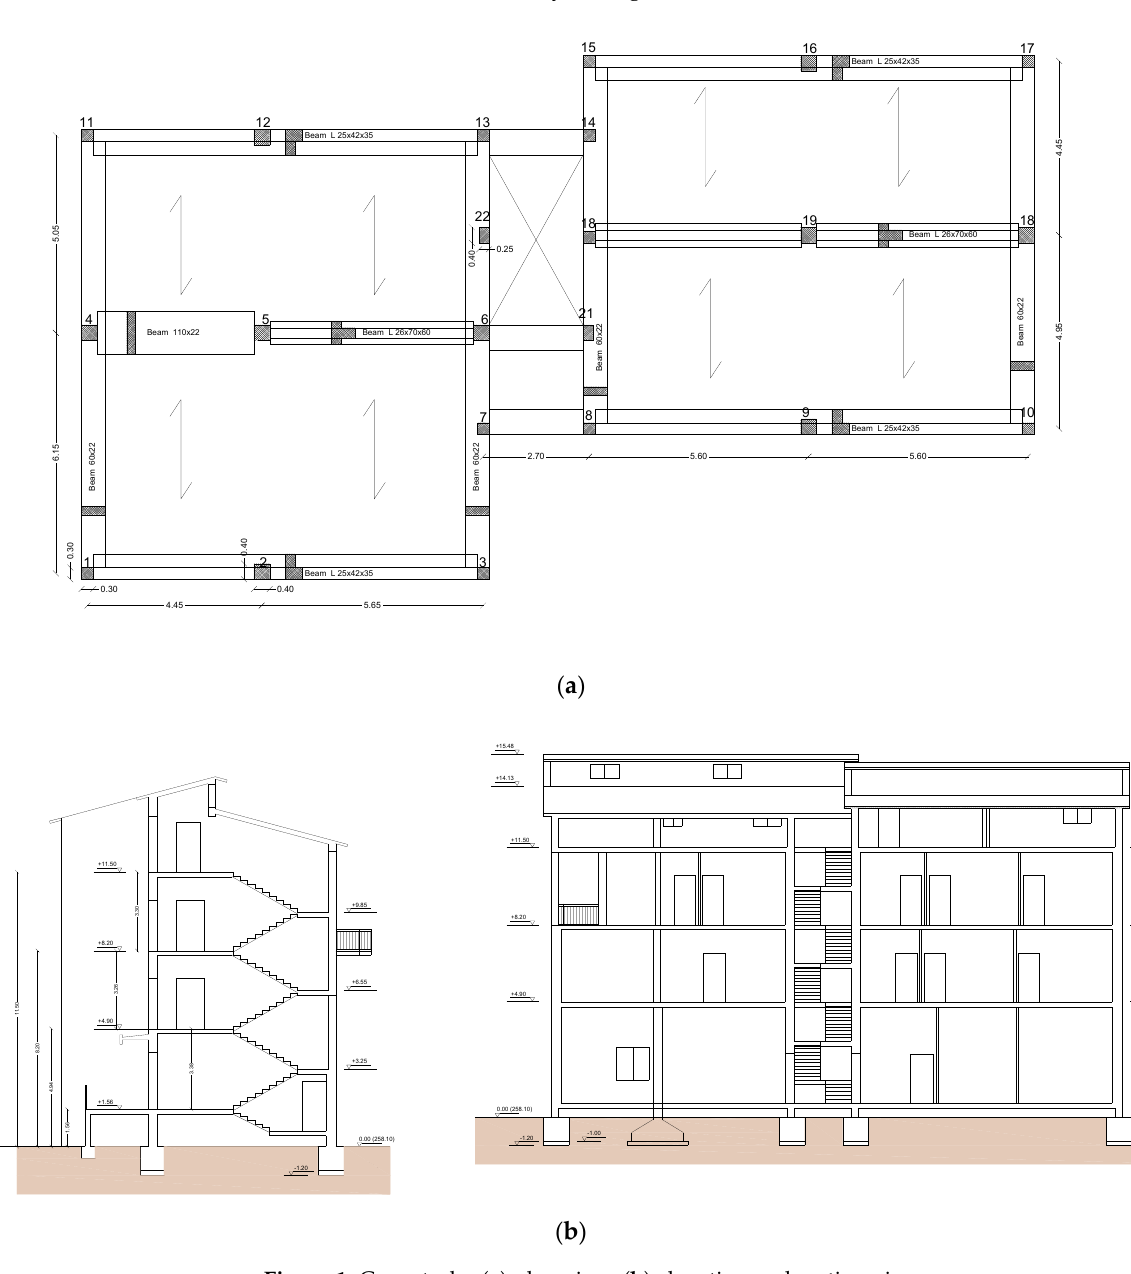
Figure 1. Case study: ( a ) plan view; ( b ) elevation and section view.